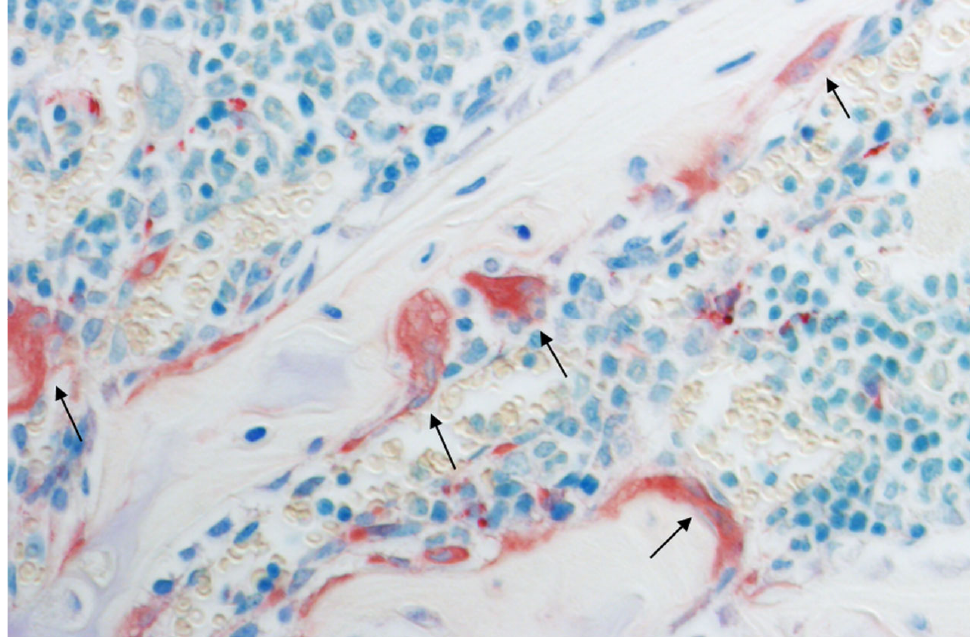
Figure 1. Multinucleated bone resorbing osteoclasts (black arrows), histological section of a mouse humerus stained with tartrate-resistant acid phosphatase (TRAP) and toluidine blue. Original magnification: 400 ×